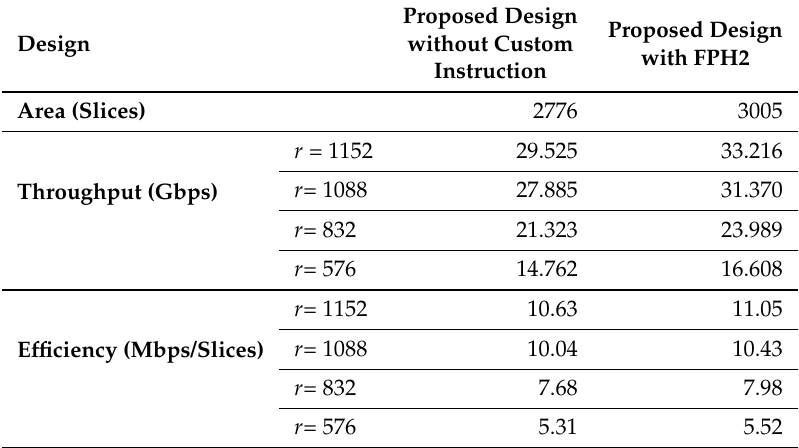
Table 6. Throughput and Efficiency results of our two